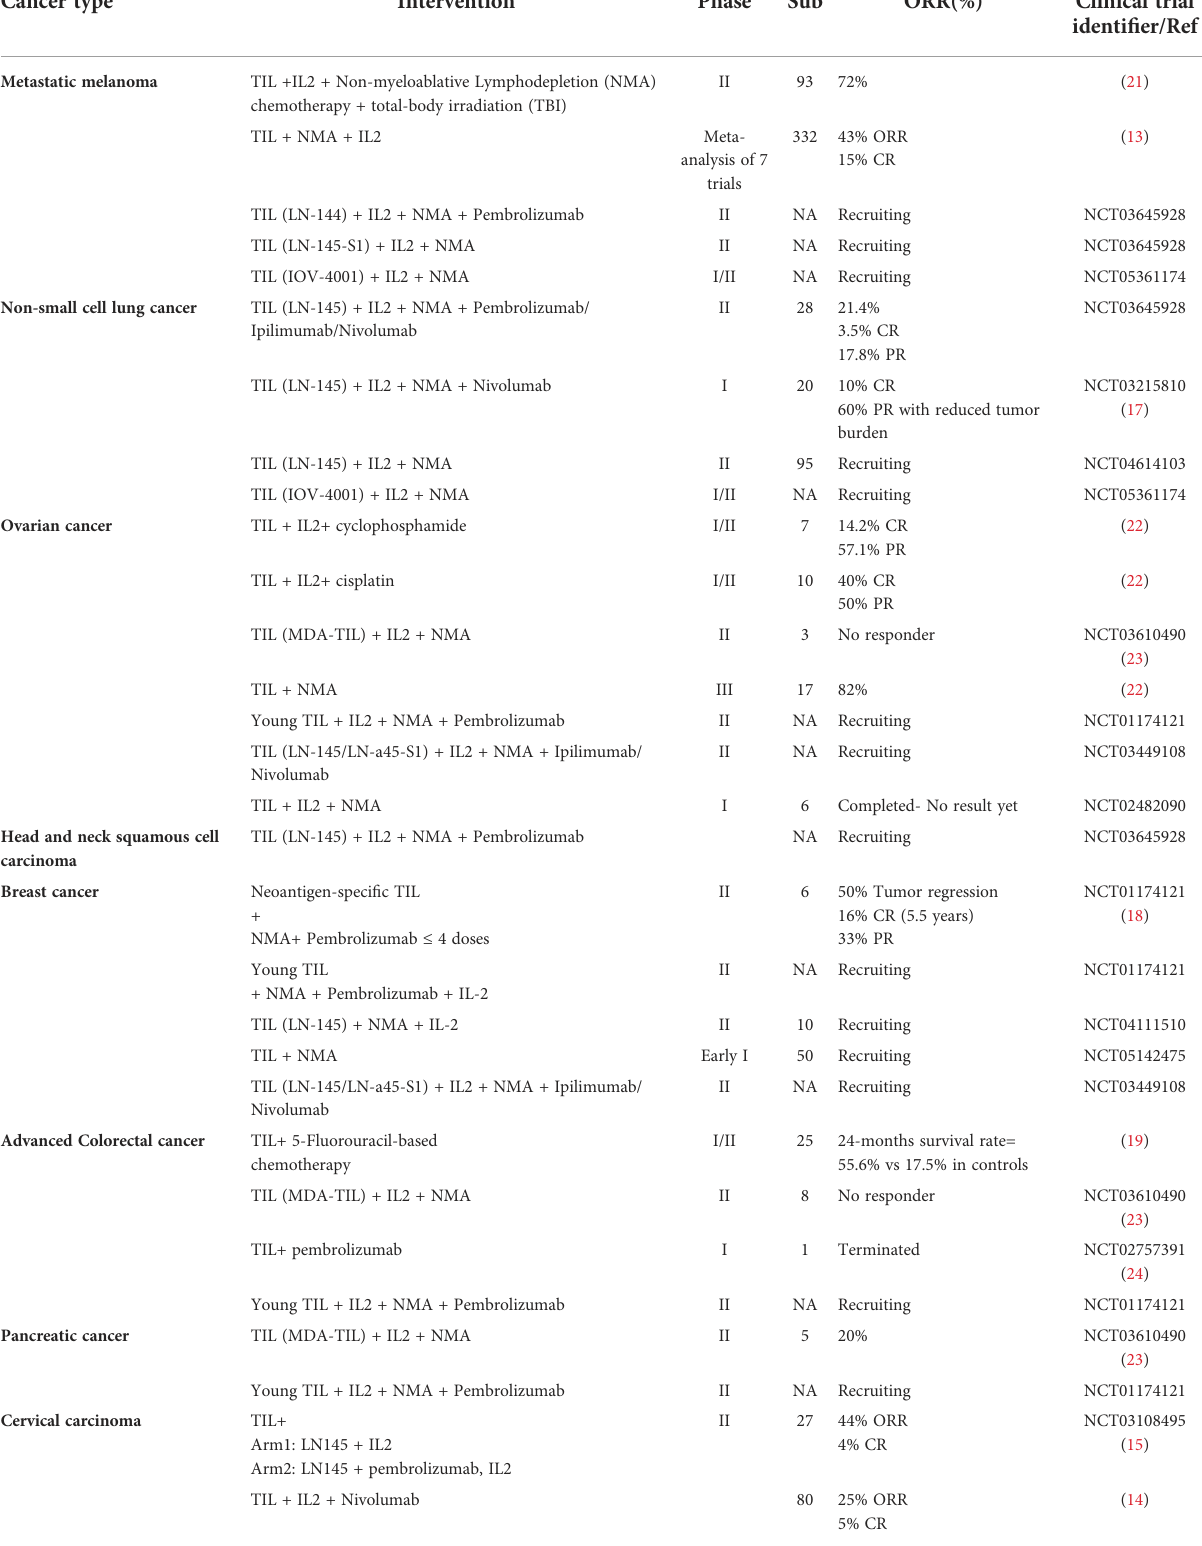
TABLE 1 Clinical trials of TIL